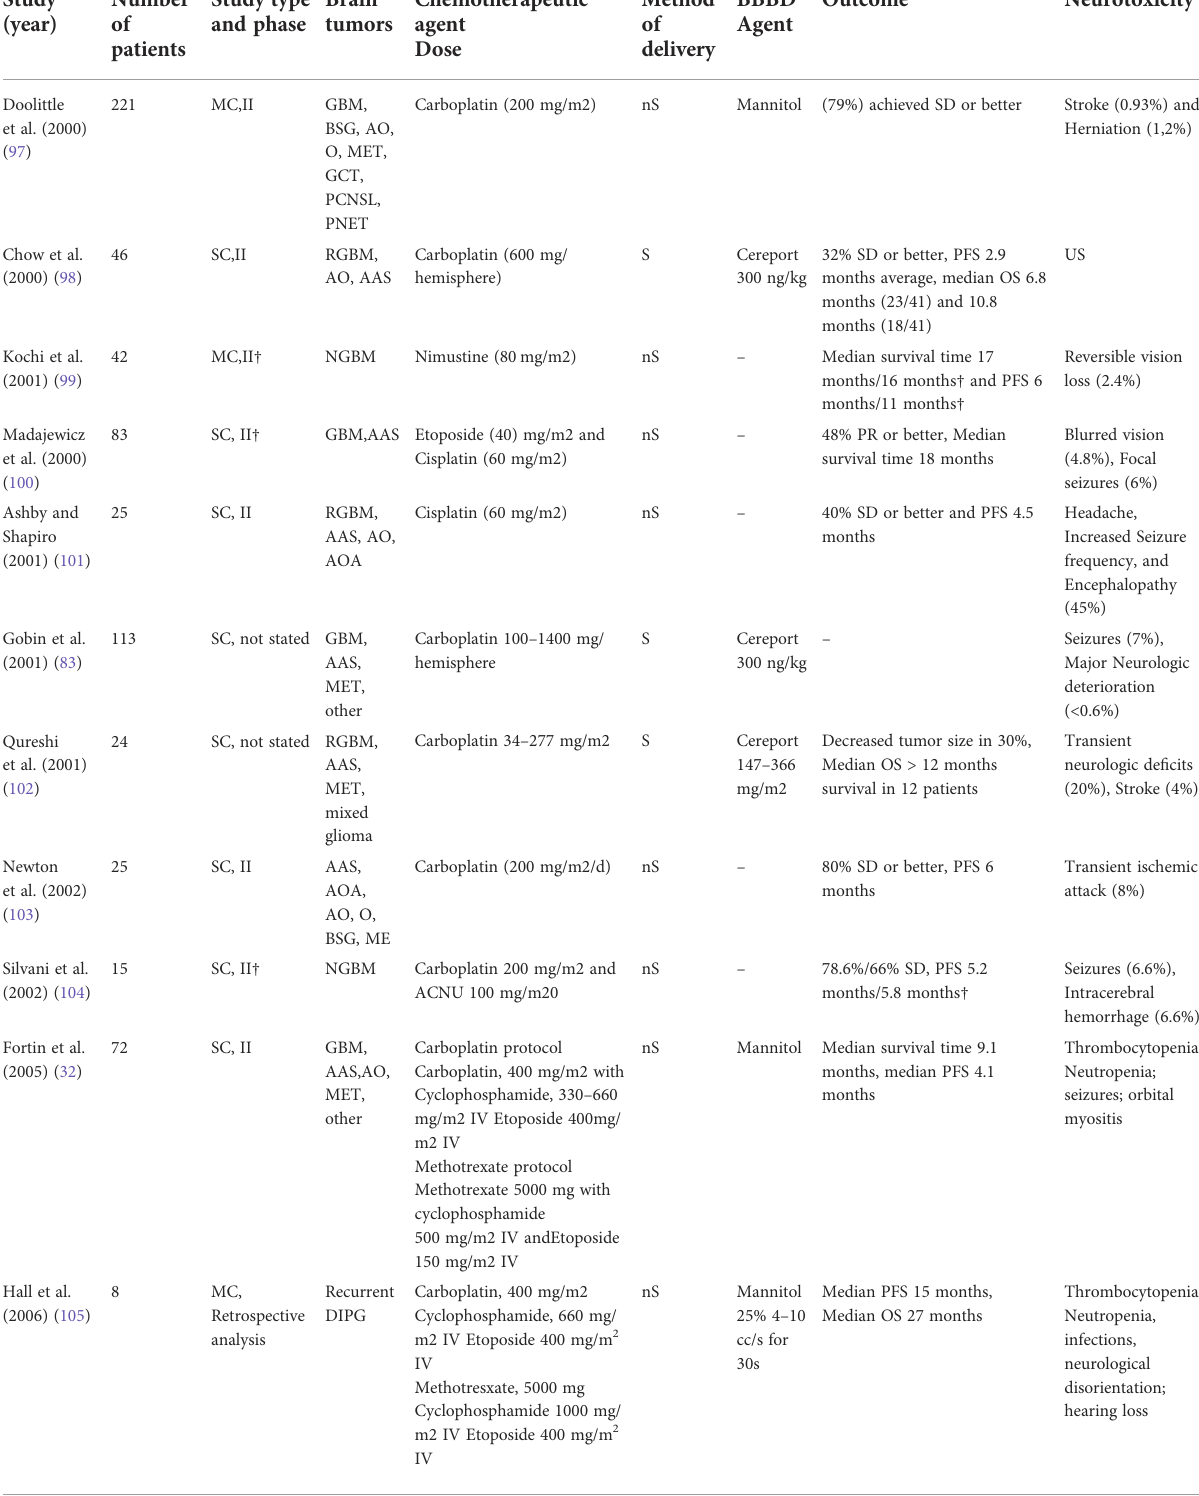
TABLE 1 Summary of studies using intra-arterial delivery of chemotherapeutics for the treatment of